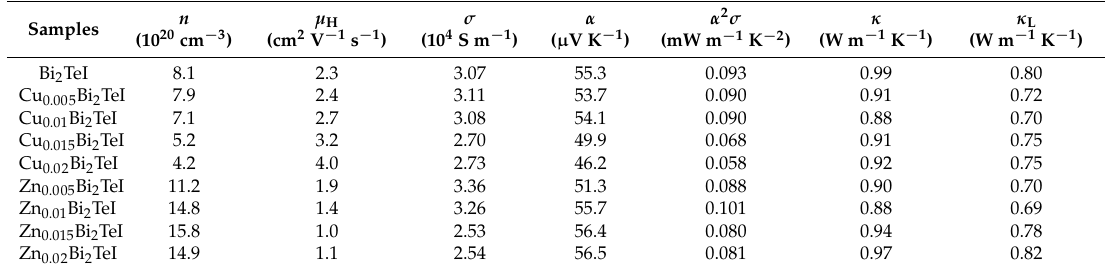
Table 2. Charge transport properties of Cu-doped Cu x Bi 2 TeI and Zn-doped Zn y Bi 2 TeI at 300 K.